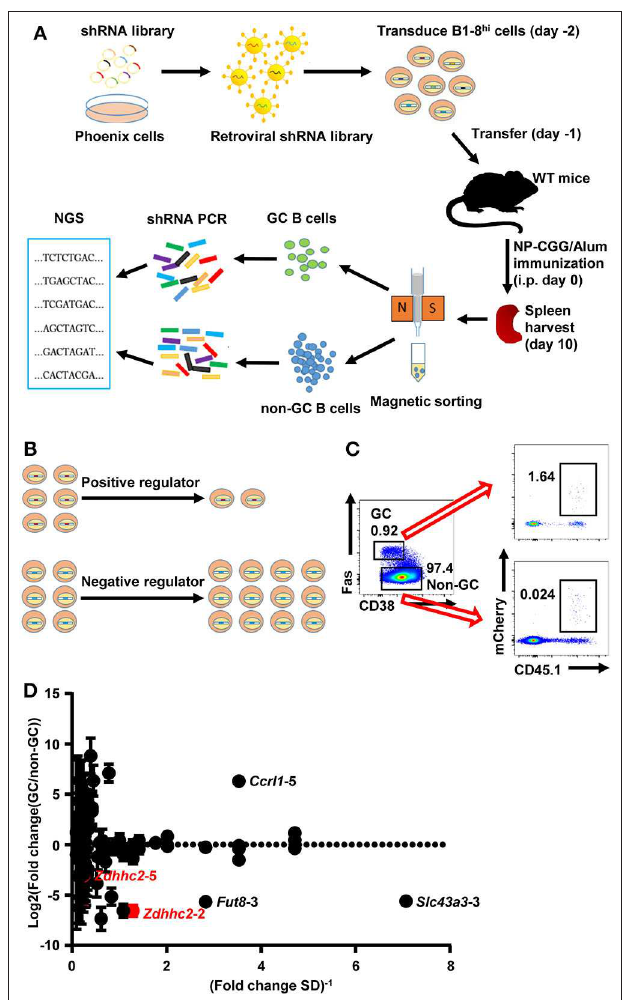
FIGURE 2 | Overview of the shRNA in vivo screening system for regulators of germinal center (GC) B cell differentiation. (A) A schematic view of the in vivo screening system for regulators of GC B cell differentiation. The shRNA retroviral library was produced in Phoenix cells and used to transduce B1-8 hi cells on day − 2, which were adoptively transferred into eight wild-type (WT) recipient mice on day − 1. These mice were immunized with NP-CGG/Alum on day 0, sacrificed on day 10, and subjected to splenic GC and non-GC B cell isolation by magnetic sorting. The shRNA sequences were amplified by PCR and determined by next-generation sequencing to evaluate the abundance of each shRNA construct. (B) Illustration of the screening strategy: shRNA constructs that target the positive regulators of GC B cell differentiation are less abundant and vice versa for negative regulators. (C) Representative flow cytometry profiles showing the percentages of retroviral shRNA library transduced cells (expressing mCherry) in GC and non-GC B cells in mice treated as described in (A) . (D) Plot of the binary logarithm of shRNA’s fold change values (calculated as the ratio of each shRNA’s abundance in GC B cells to that in the corresponding non-GC B cells) against the reciprocals of their standard deviations [(fold change SD) − 1 ]. Two independent screens were